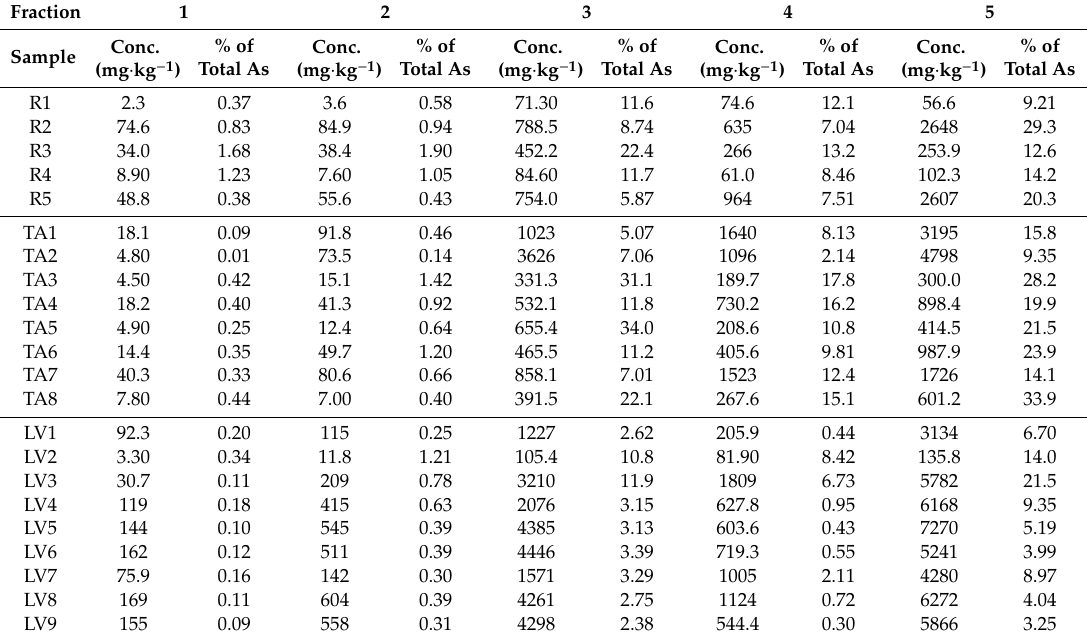
Table 2. As contents in the di ff erent fractions for each